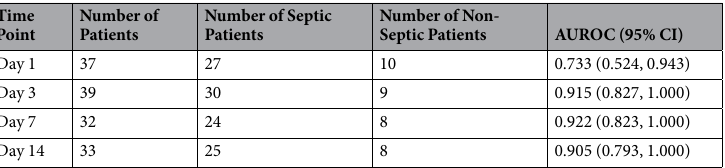
Table 3. Discriminatory power of a combination of NEUT-Y and platelet impedance count (PLT-I) for sepsis at different time points was assessed through area under the receiver operating characteristic curve (AUROC) analysis and shown with 95% confidence